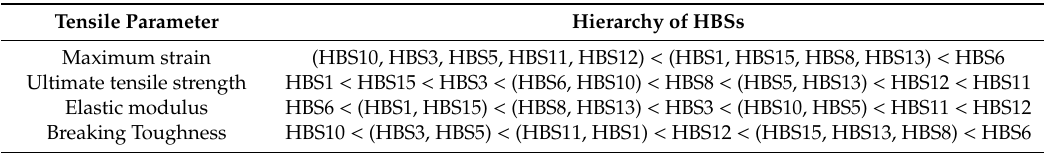
Table 3. HBSs order based on Duncan ʹ s test results in each evaluated tensile parameter.